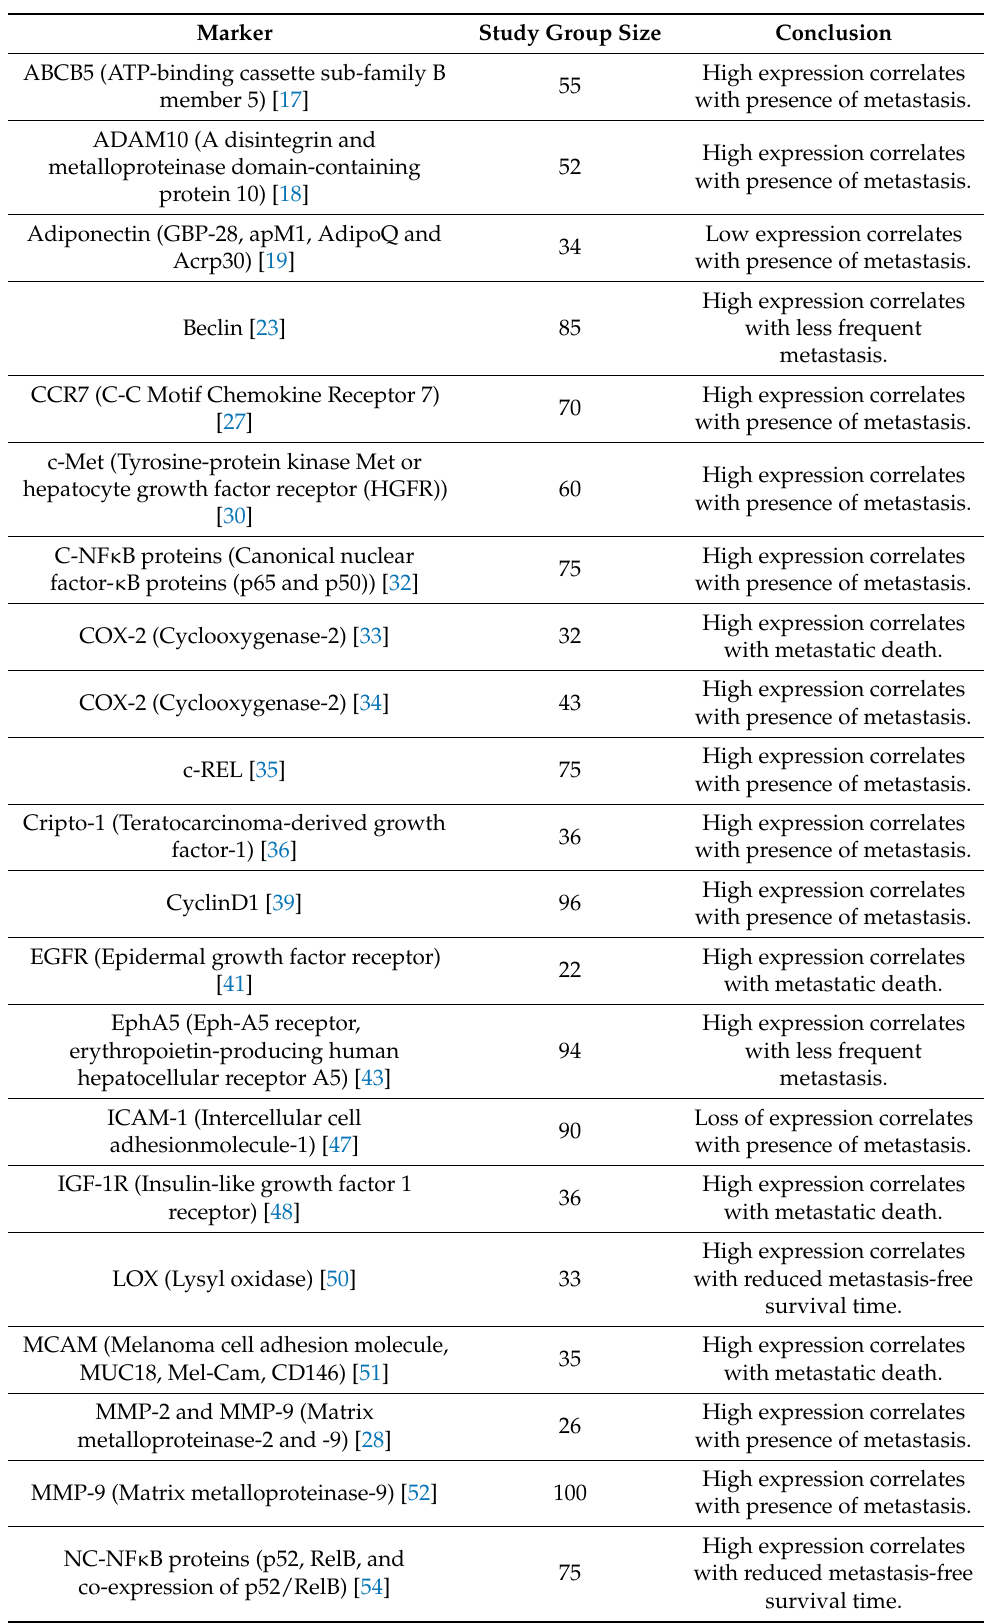
Table 11. Summary of markers whose expression is related to metastasis